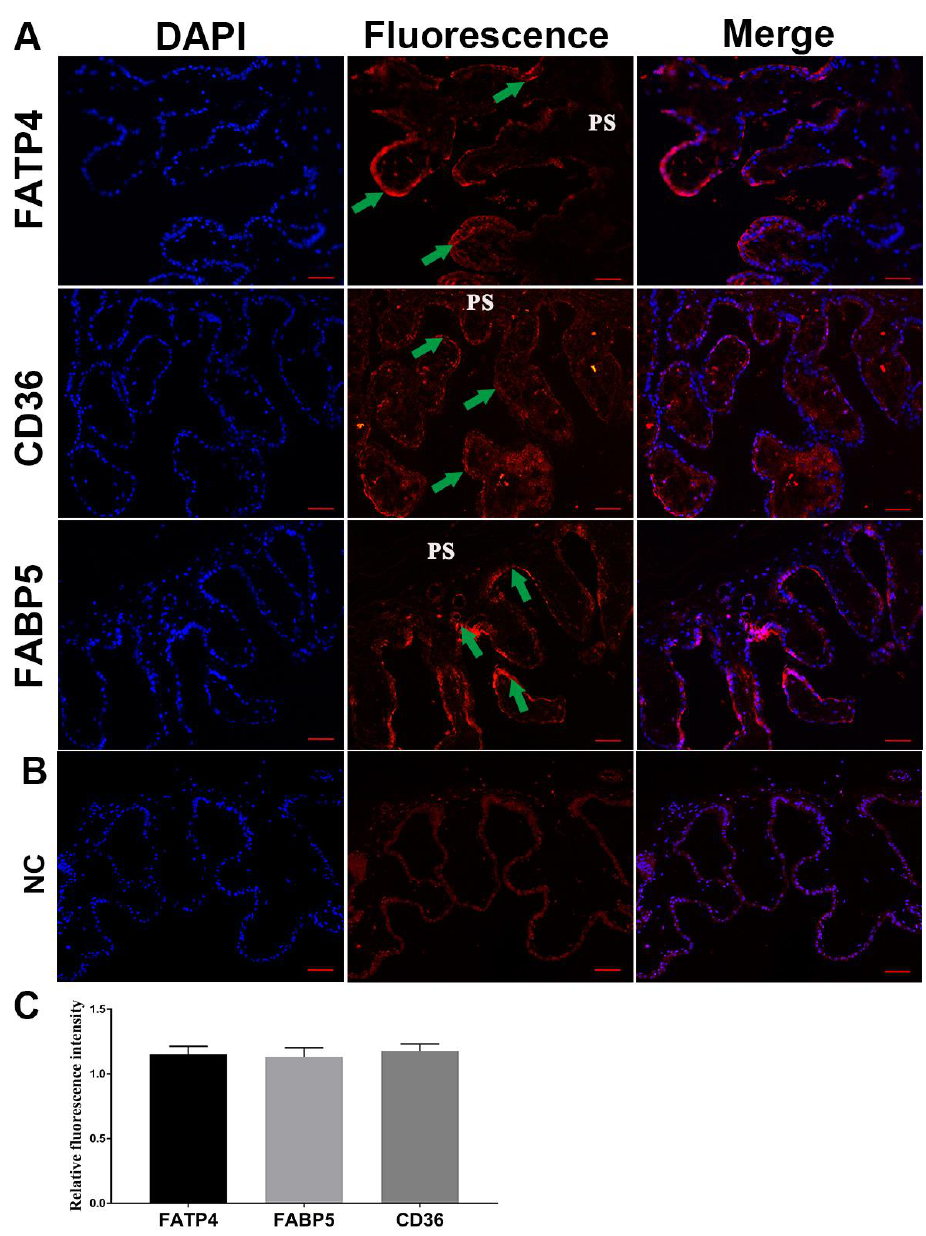
Figure 4. Localization of FATP4, CD36, and FABP5 by IF in pig term placentae. ( A ) Left column: nuclear staining with 4′,6-Diamidino-2-Phenylindole (DAPI); middle column, localization, and expression of FATP4, CD36, and FABP5 detected by IF staining; right column, merged images of DAPI and fluorescence. ( B ) Negative control (NC), where normal mouse IgG were substituted for primary antibody. ( C ) Relative quantification of fluorescence intensity of FATP4, CD36, and FABP5 protein in full-term pig placentae. PS, placental stroma; green arrow, cytotrophoblastic layer. Scale bar = 100 µ